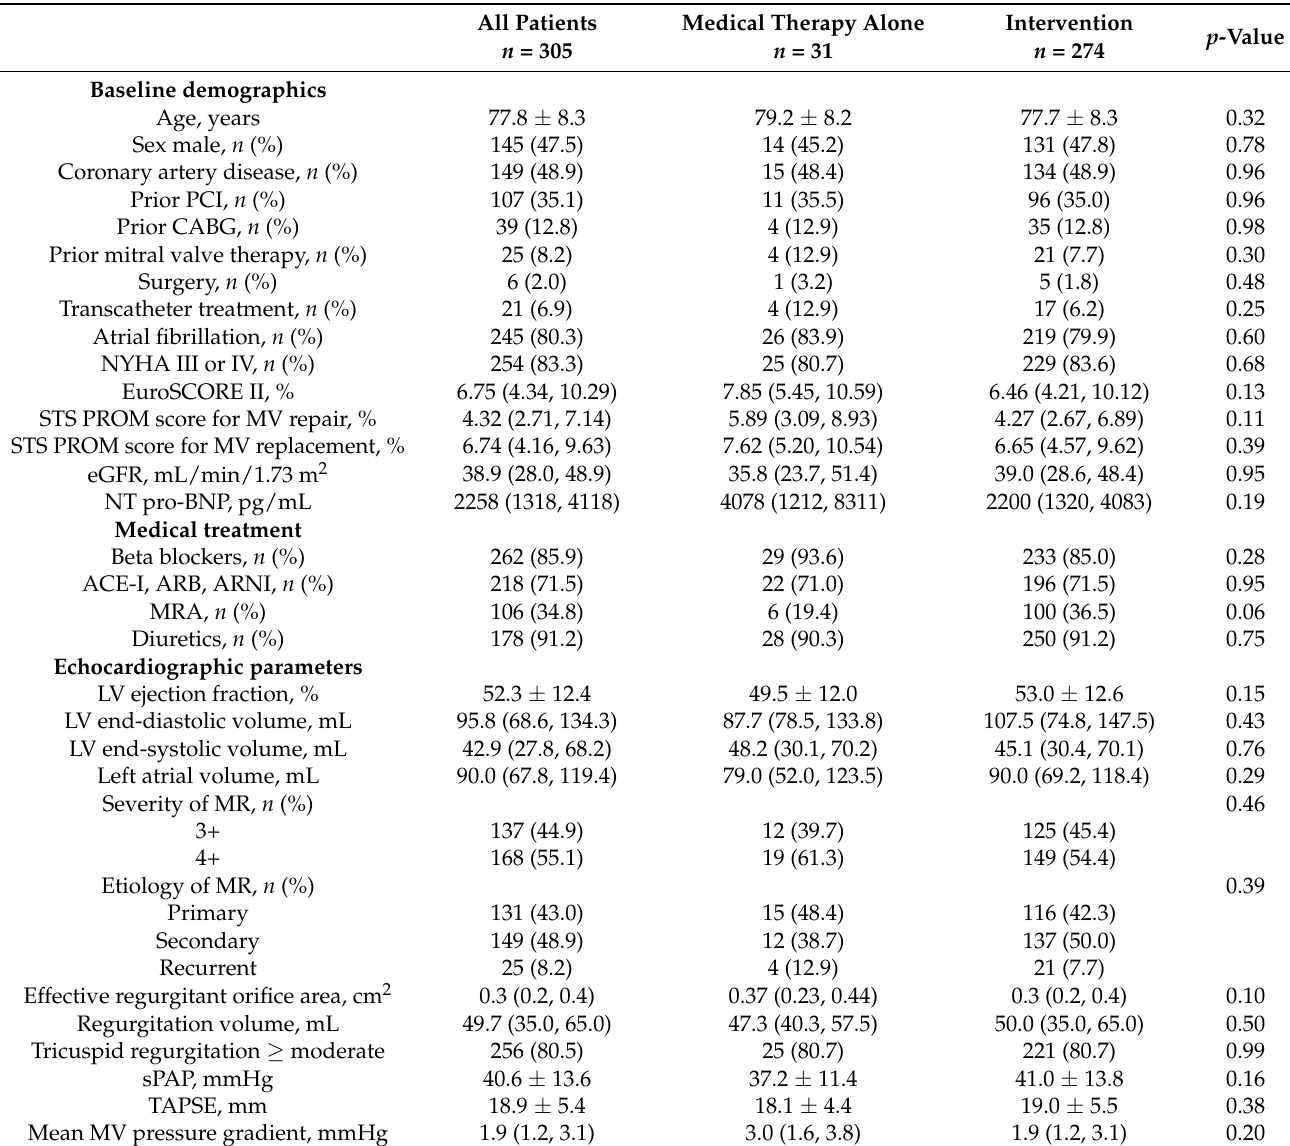
Table 1. Patient